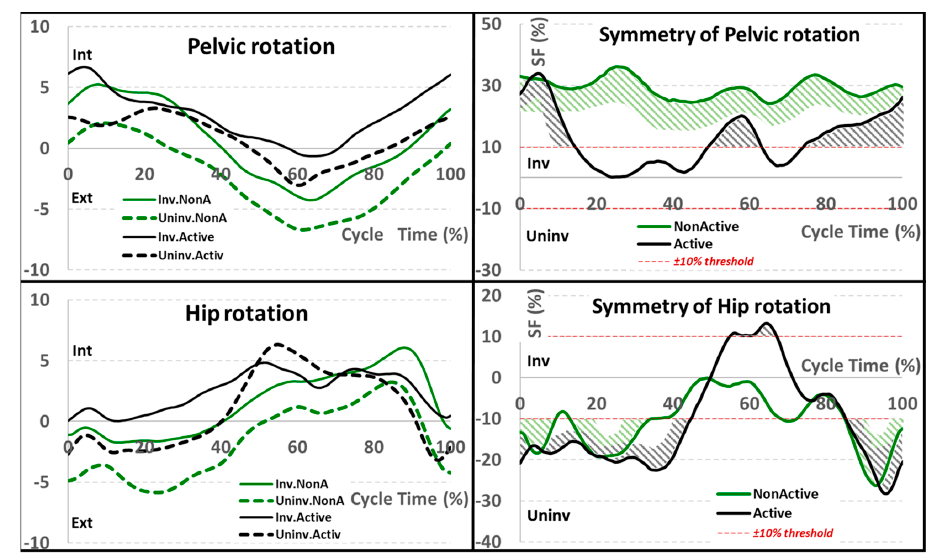
Figure 4. Transverse plane kinematics for pelvis and hip joints (in degrees) for both involved/uninvolved limb and active/non-active groups ( on the left ); corresponding symmetry function (SF in percent) for the active/non-active groups ( on the right ). The area exceeding the ±10% threshold was highlighted to discriminate between symmetrical and asymmetrical patterns. All angles are in degrees and the SF in percentage.